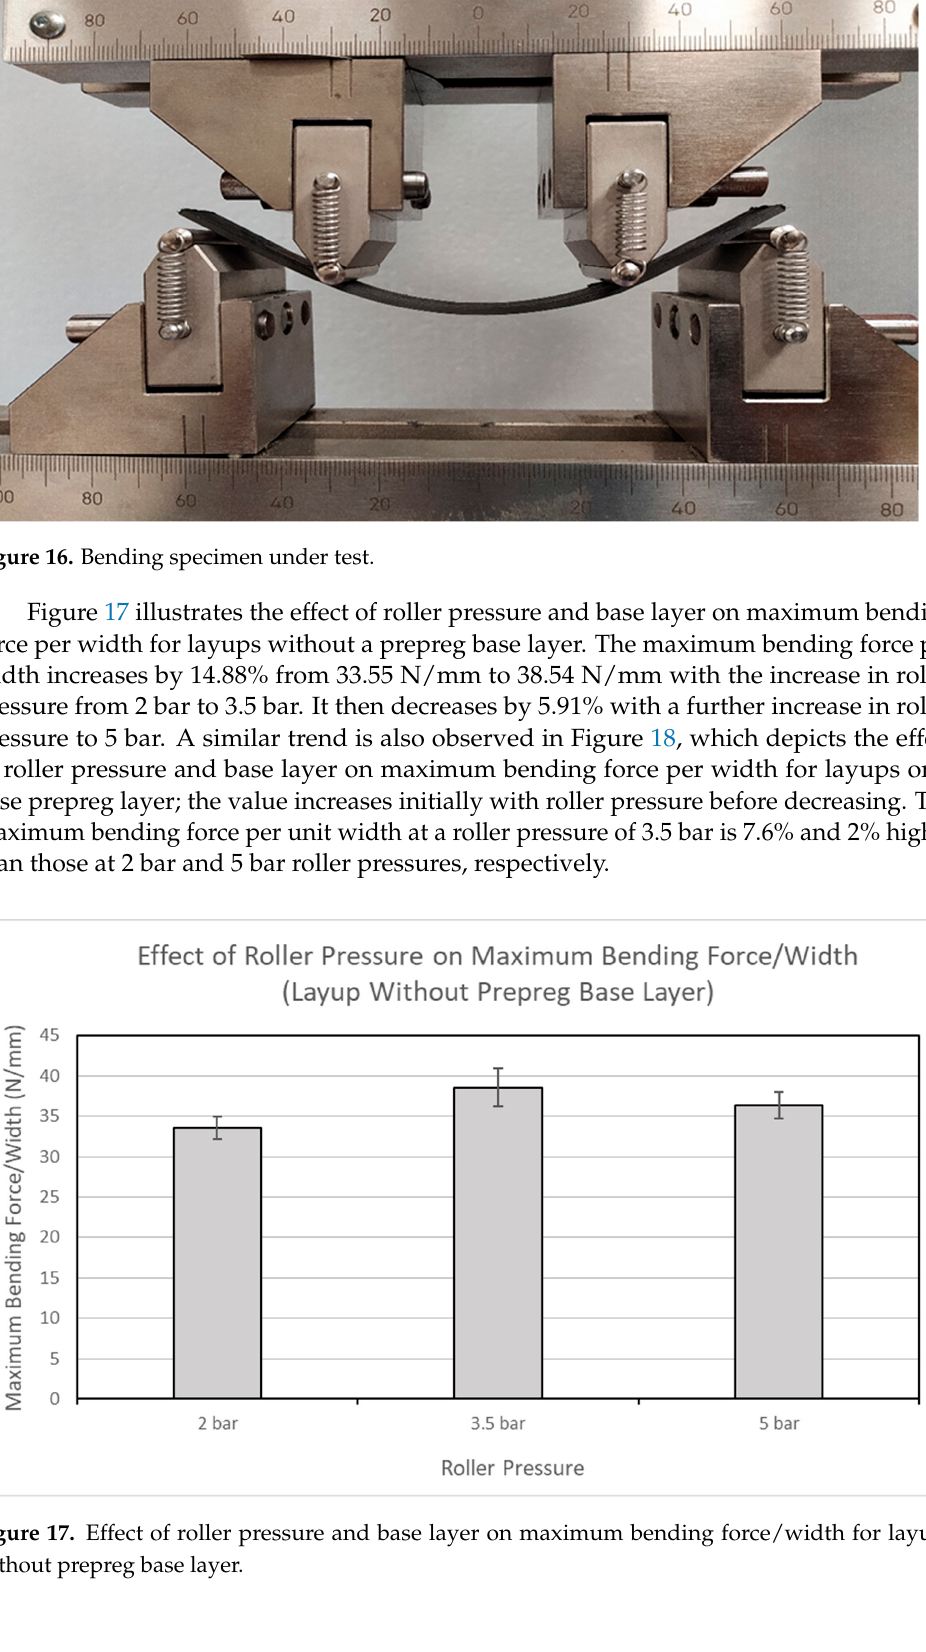
Figure 18. Effect of roller pressure and base layer on maximum bending force/width for layups on prepreg base layer. The maximum bending force per unit width for different batches of specimens is tab- ulated in Table 4. TY1_B with 41.09 N/mm exhibited the highest maximum bending force per unit width while TY6_B with 33.55 N/mm exhibited the lowest. The maximum calcu- lated coefficient of variation among all the sets of laminates is 6.06%. Table 4. Maximum bending force per unit width for different batches of specimens. Laminate Label